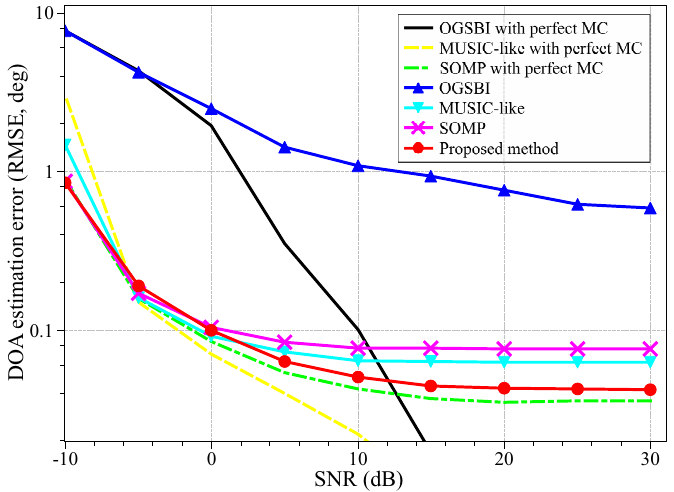
Figure 5. DOA estimation performance with different